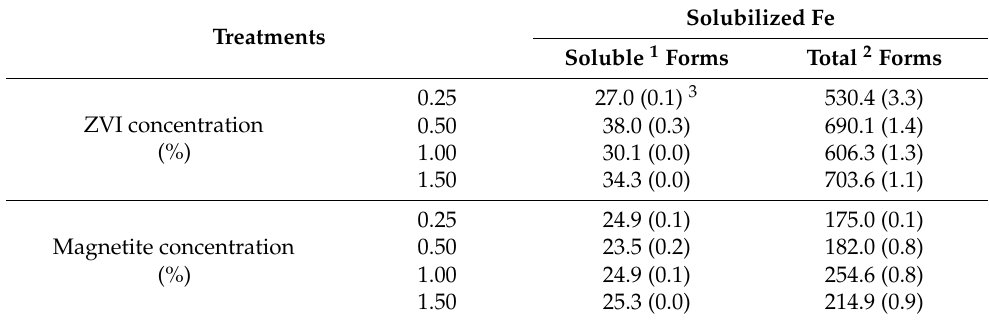
Table 5. Concentration of the solubilized Fe in the ZVI and the magnetite (Fe 3 O 4 ) treatment